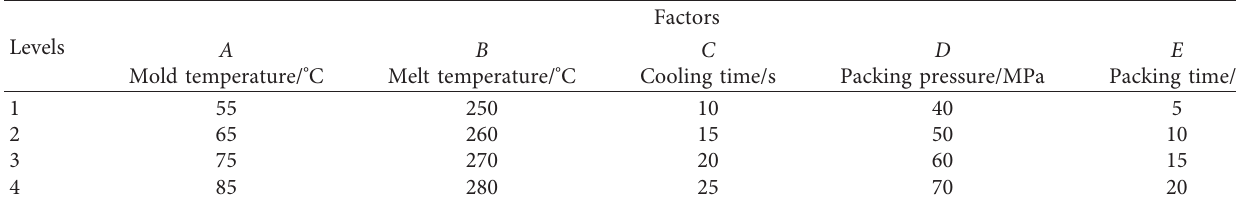
Table 2: Level factor setting.